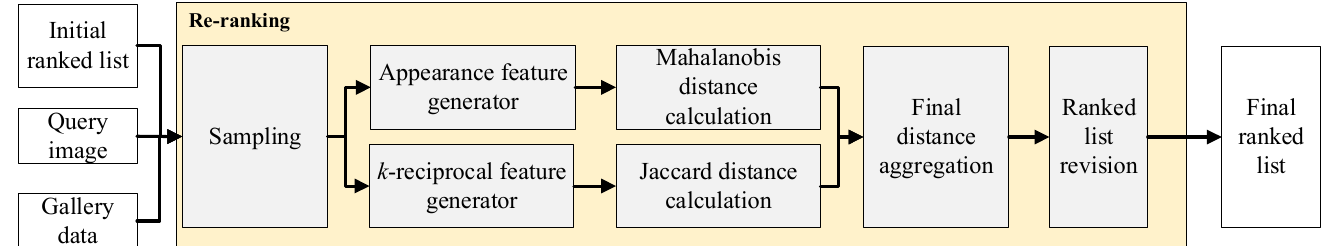
Figure 4. Re-ranking strategy [30] © 2022 IEEE.